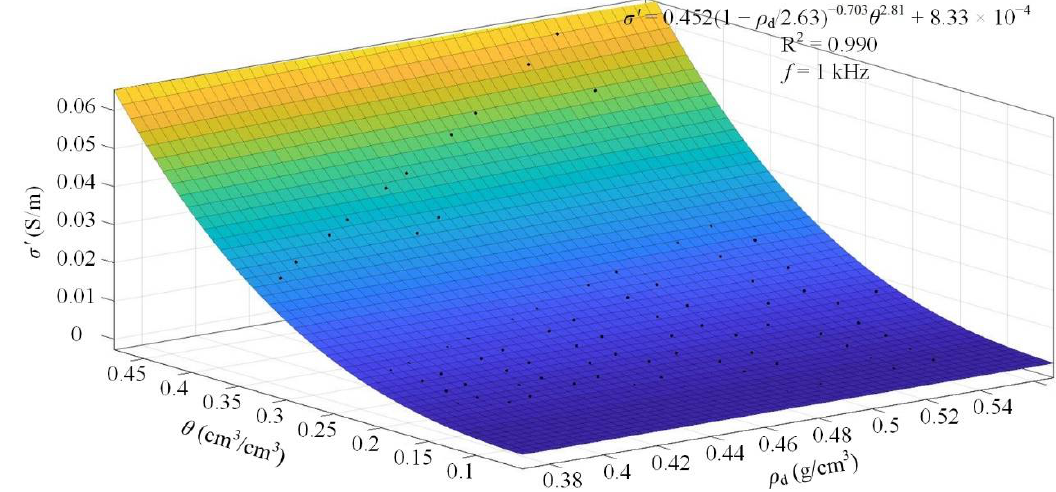
Figure 9. Fitted relation for in-phase substrate conductivity as a function of volumetric water content and dry density at the frequency of 1 kHz. The related dry densities and VWCs are shown in Tables S1 and S2, respectively.